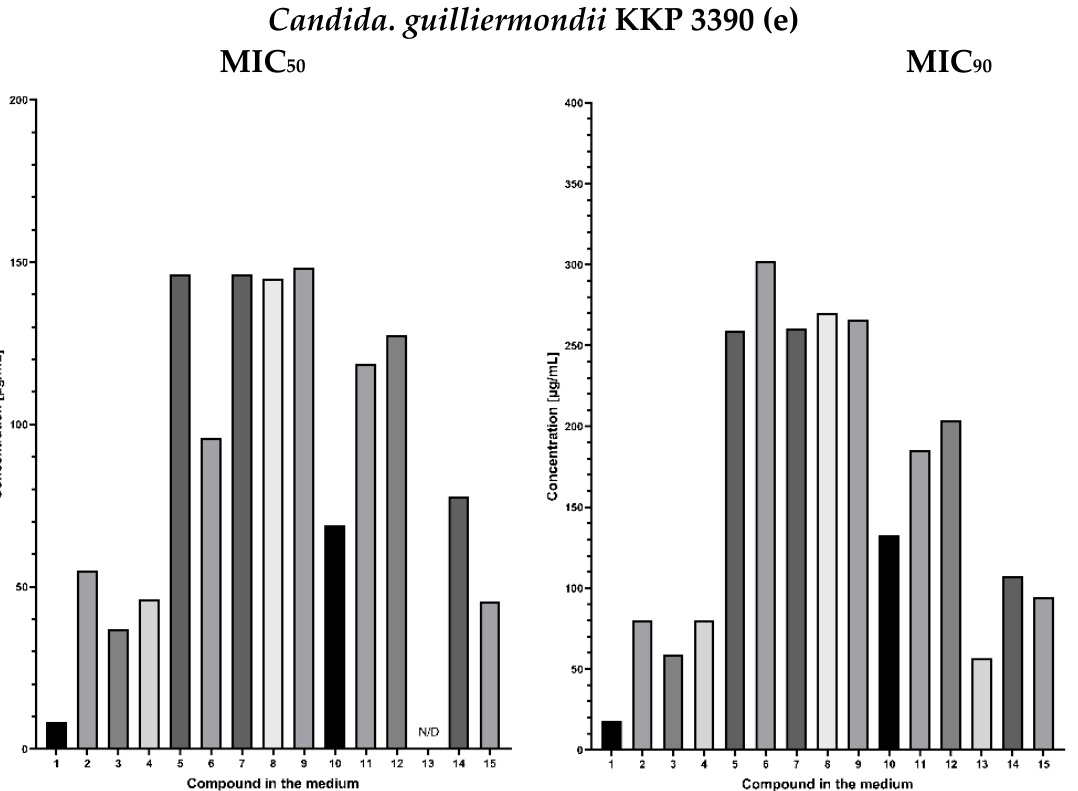
Figure 13. Experimentally determined fungistatic activity of fluconazole and lactones 2–4 and fluconazole analogues 5–15 derivative against Candida albicans ATCC 10231, C. albicans ATCC 2091, C. zeylanoides KKP 3528, and C. guilliermondii KKP 3390 ( a – e ). MIC values are in µg/mL. MIC 50 : the